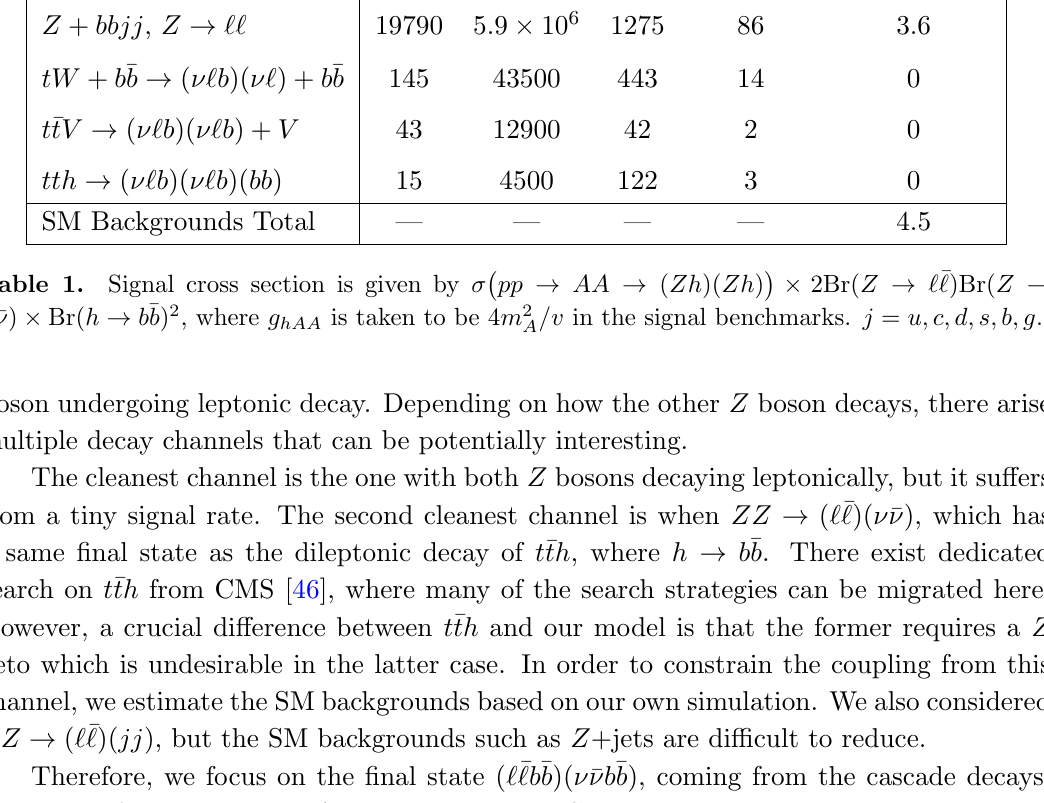
Table 1. Signal cross section is given by (cid:27) (cid:23) (cid:22) (cid:23) ) (cid:2) Br( h ! b (cid:22) b ) 2 , where g hAA is taken to be 4 m 2